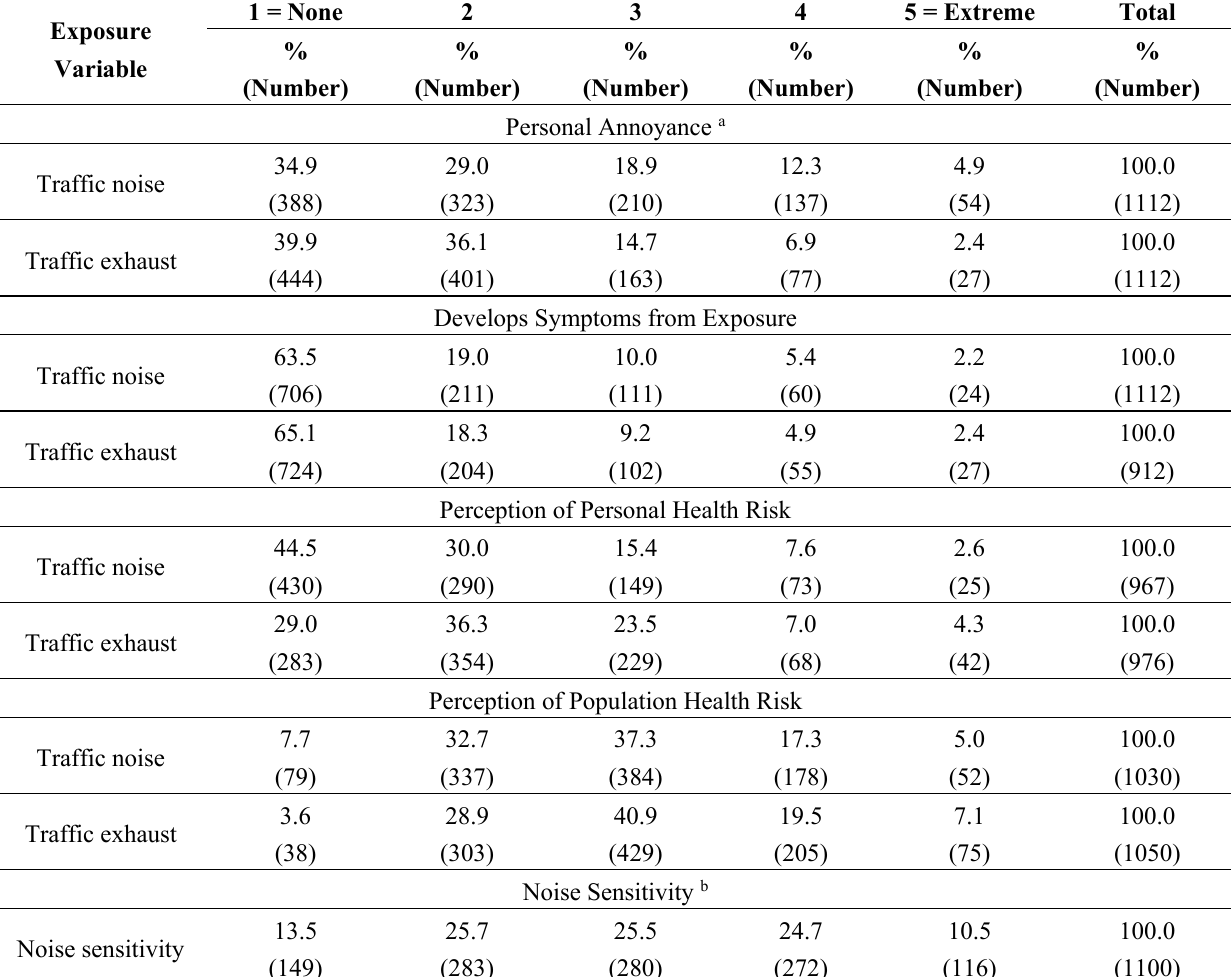
Table 3. Self-rated feelings relating to road-traffic noise and exhaust